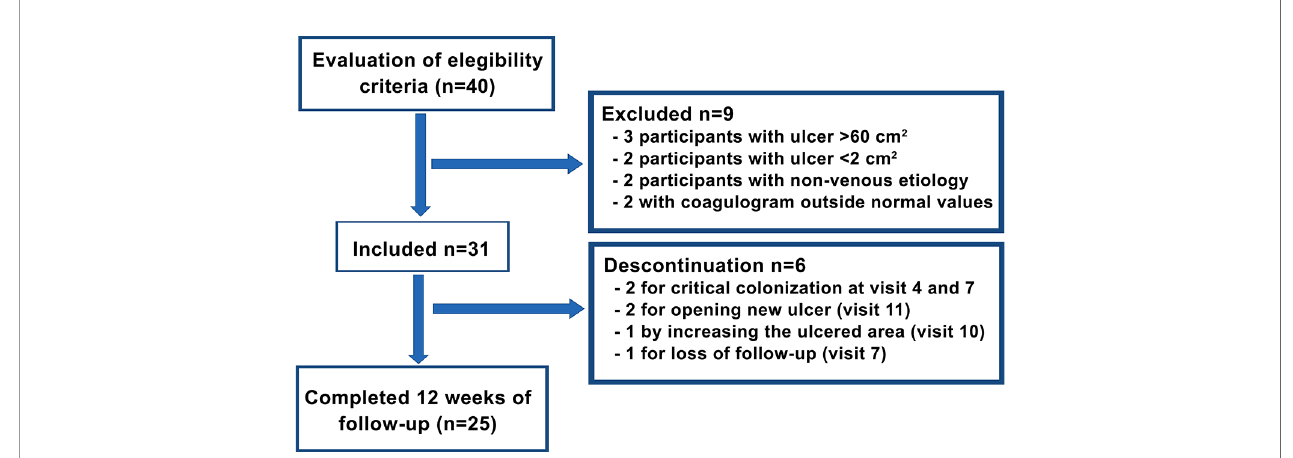
FIGURE 2 | Study fl owchart.